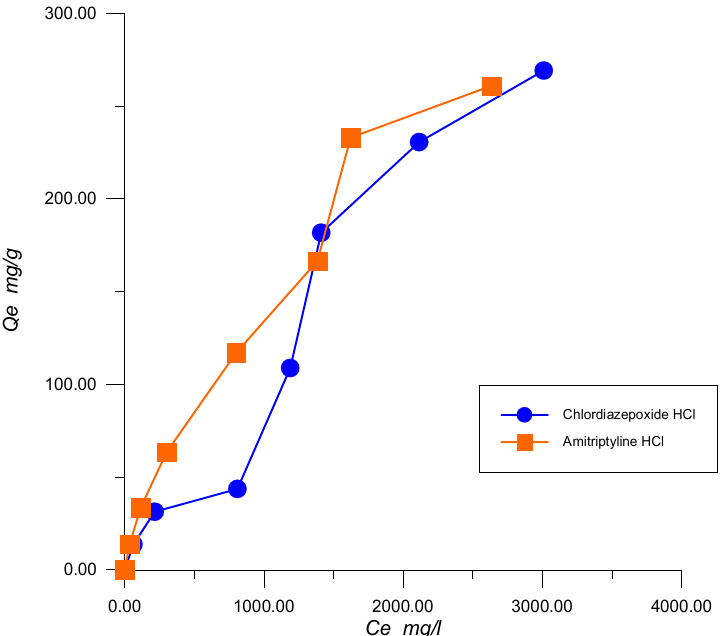
Figure 4: Adsorption isotherms of amitriptyline HCl and chlordiazepoxide HCl at pH=1 and temp.= 37.5 o